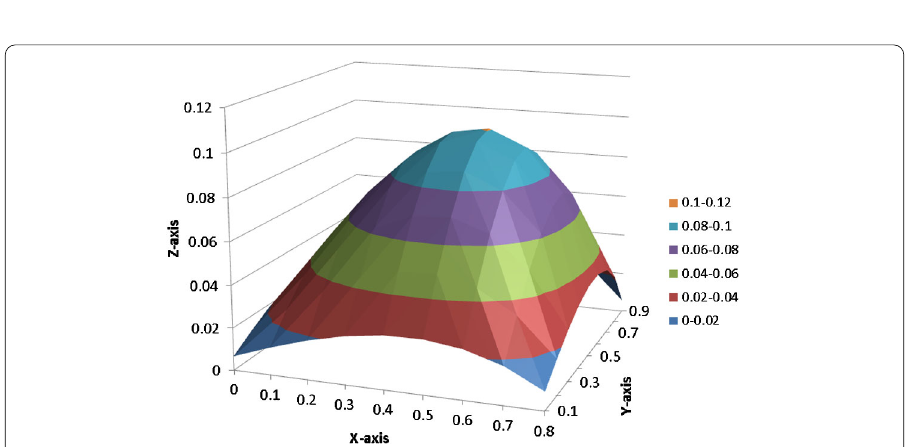
Figure 7 Numerical solution by the FSkG(C-N) method when α = 0.65 of Example 1